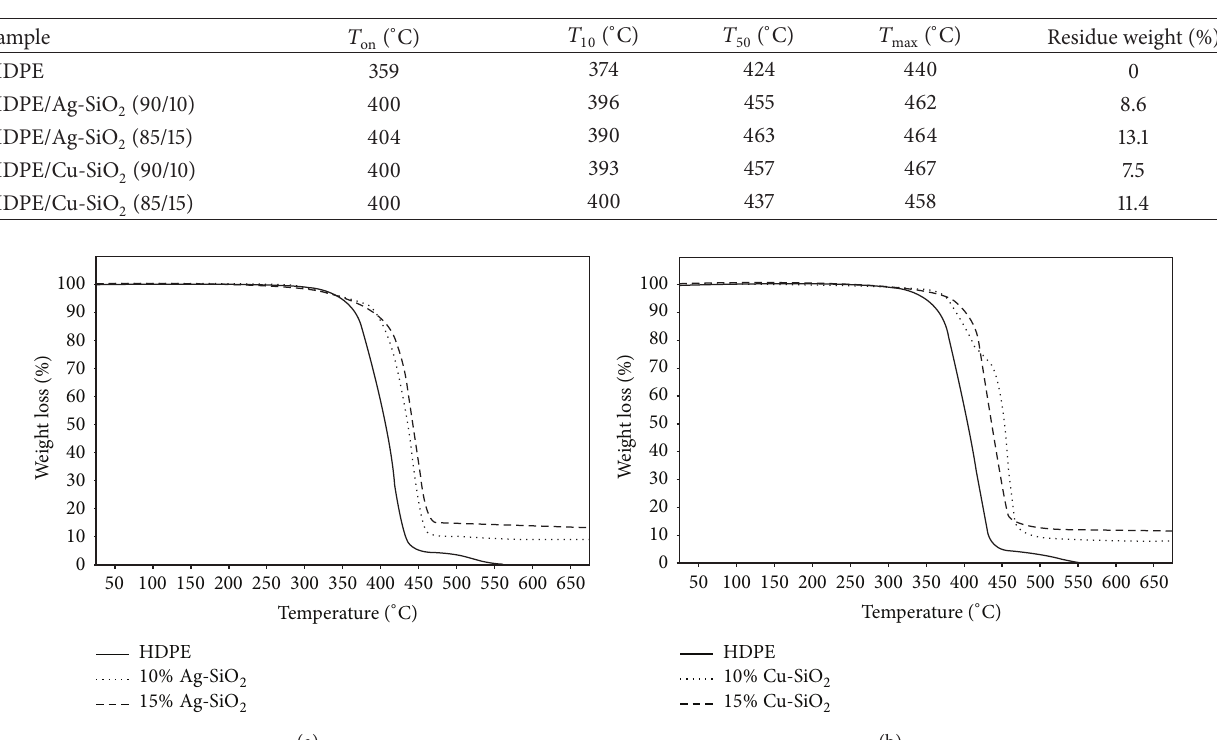
Table 4: TGA test: thermooxidative decomposition temperatures of HDPE-based composites filled by different weight percentages of Ag- or Cu-SiO . SiO 2 2